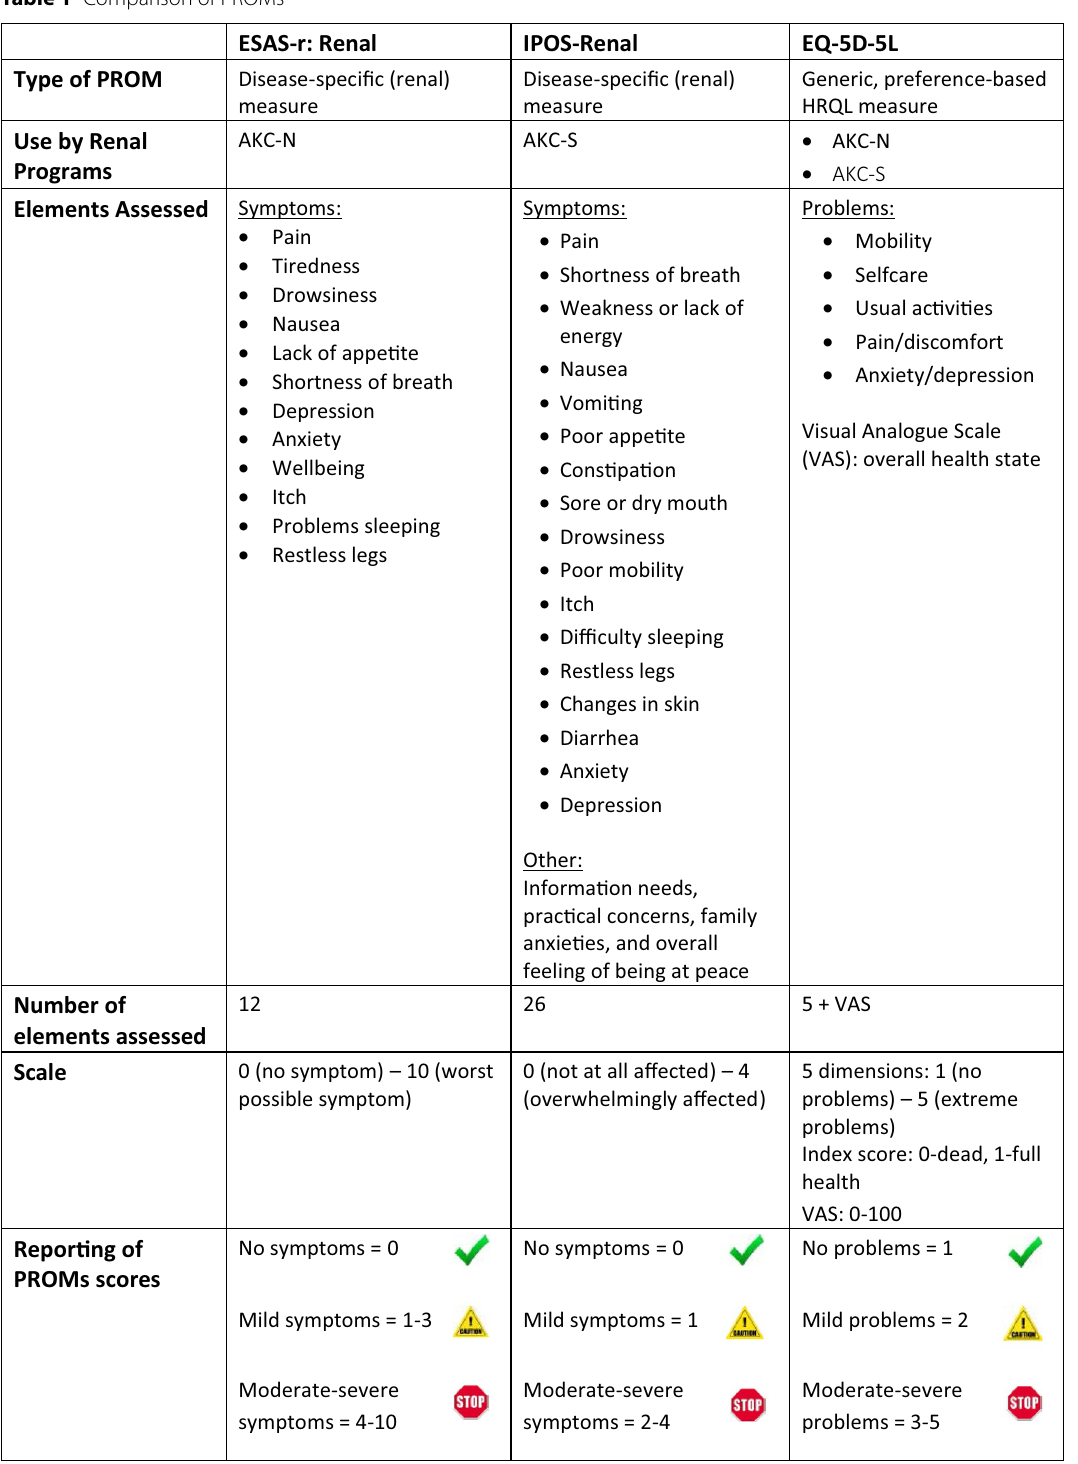
Table 1 Comparison of PROMs